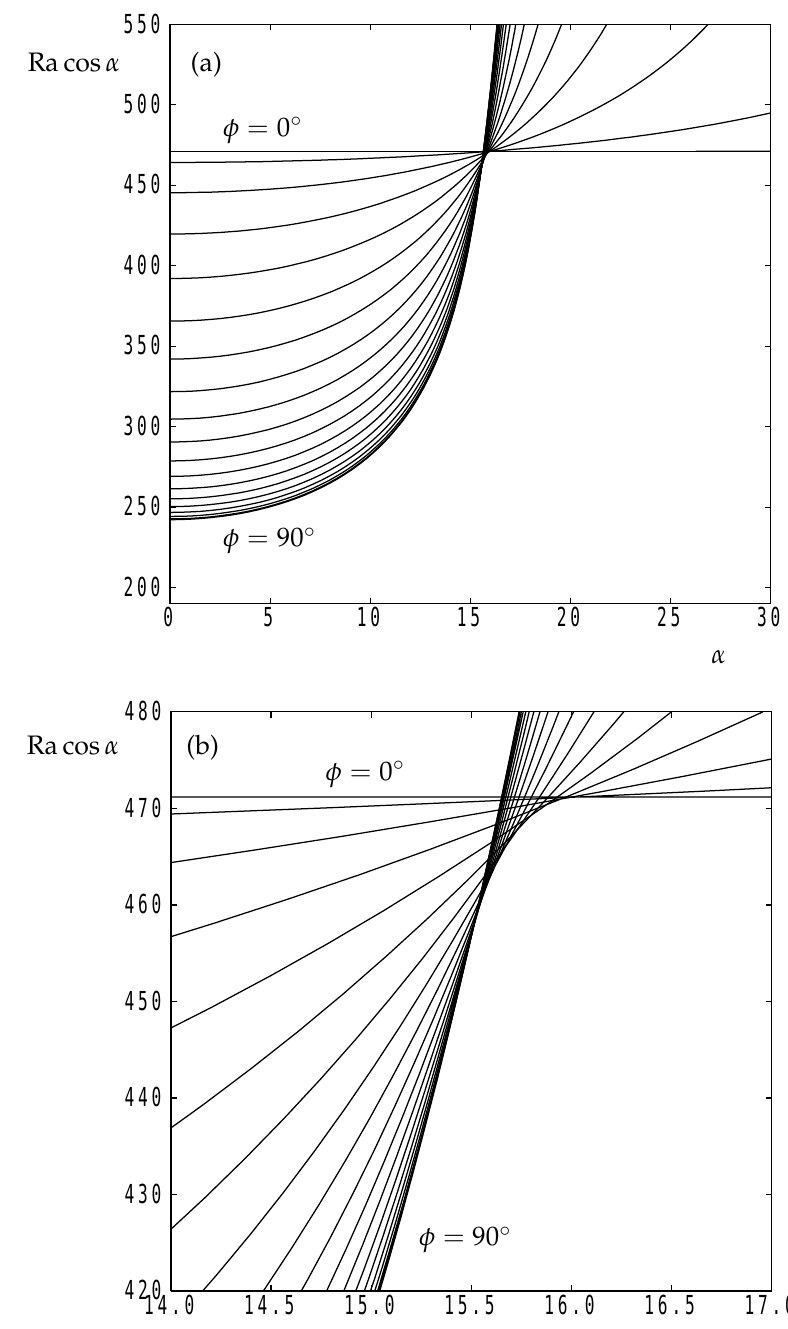
Figure 9. For ξ = 5. ( a ) the variation with α of the critical value of Ra cos α for the roll orientations, φ = 0 ◦ , 5 ◦ , 10 ◦ , . . . , 90 ◦ . ( b ) Showing a close-up view of the smooth transition between transverse and longitudinal rolls.